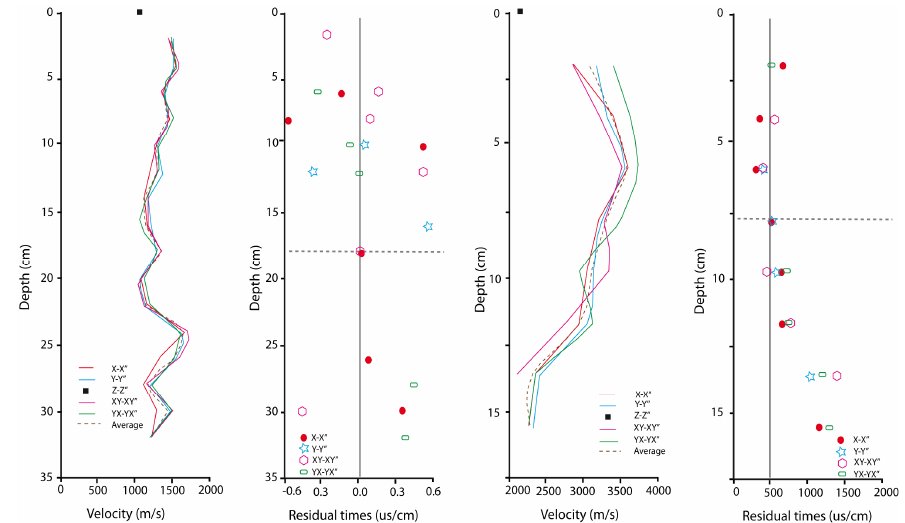
Figure 3. Examples of the results of ultrasound measurements (P-wave velocity and residual time values) on one sample of the Escucha sandstones (Mave site) ( left ) and one of the Utrillas sandstones (Olleros site) ( right ). Both the vertical/horizontal anisotropy and the heterogeneity are more significant in the Utrillas sansdstones.